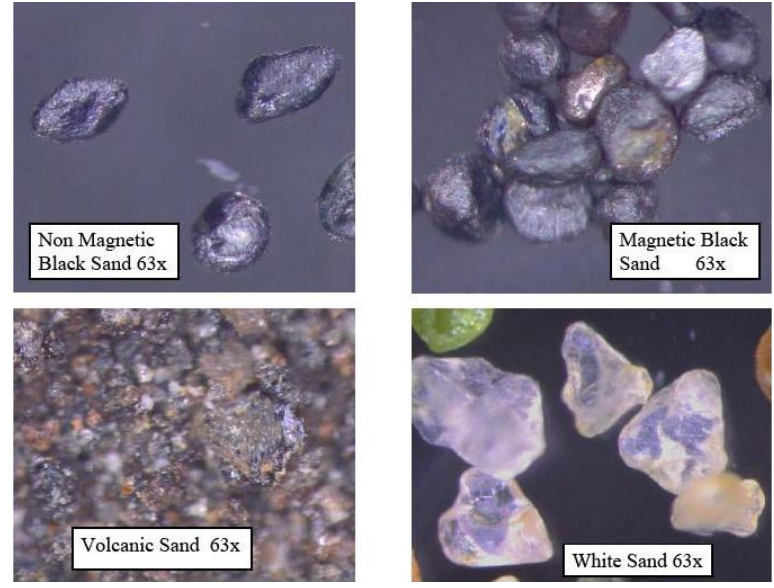
Figure 3. Stereo micrograph of non-magnetic black, magnetic black, white, and volcanic sand (63×